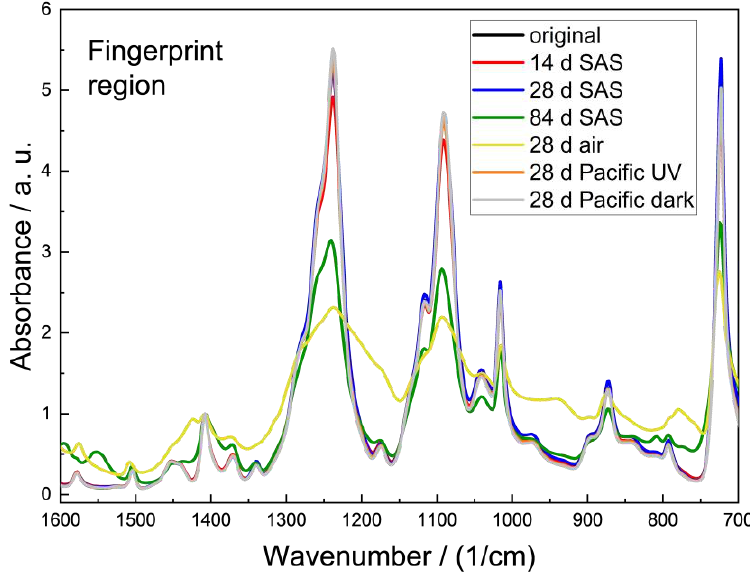
Figure 5. Comparison of the fingerprint regions in the FTIR spectra of differently weathered PET sheets (colored lines) with the original sample. The black line of the original sample lies exactly behind the orange one. The strongest signs of weathering are shown by the 84-day weathered sample (green) and the air-weathered sample (yellow) by decreasing absorbance and the widening of the bands.